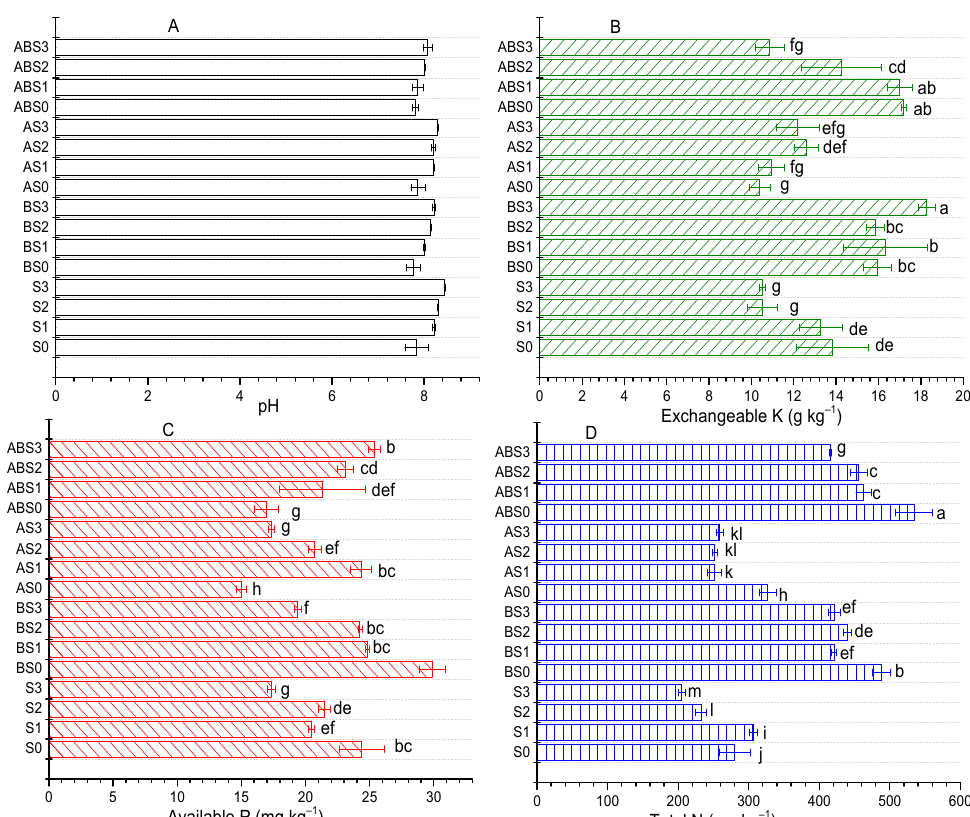
Figure 1. Influence of Arbuscular mycorrhizal fungi (AMF) and biochar on ( A ) soil pH, ( B ) exchangeable K, ( C ) available P, and ( D ) total N after harvesting. Data present the mean ± standard deviation of three replicates and mean values followed by different letters are significantly different at p < 0.05 according to Duncan multiple range test. S0, S1, S2, and S3 (0, 50, 100, and 150 Mm NaCl treatment, respectively); BS0, BS1, BS2 and BS3 (biochar + 0, 50, 100, and 150 Mm NaCl treatment, respectively); AS0, AS1, AS2 and AS3 (AMF + 0, 50, 100, and 150 Mm NaCl treatment, respectively); ABS0, ABS1, ABS2 and ABS3 (biochar + AMF + 0, 50, 100, and 150 Mm NaCl treatment,